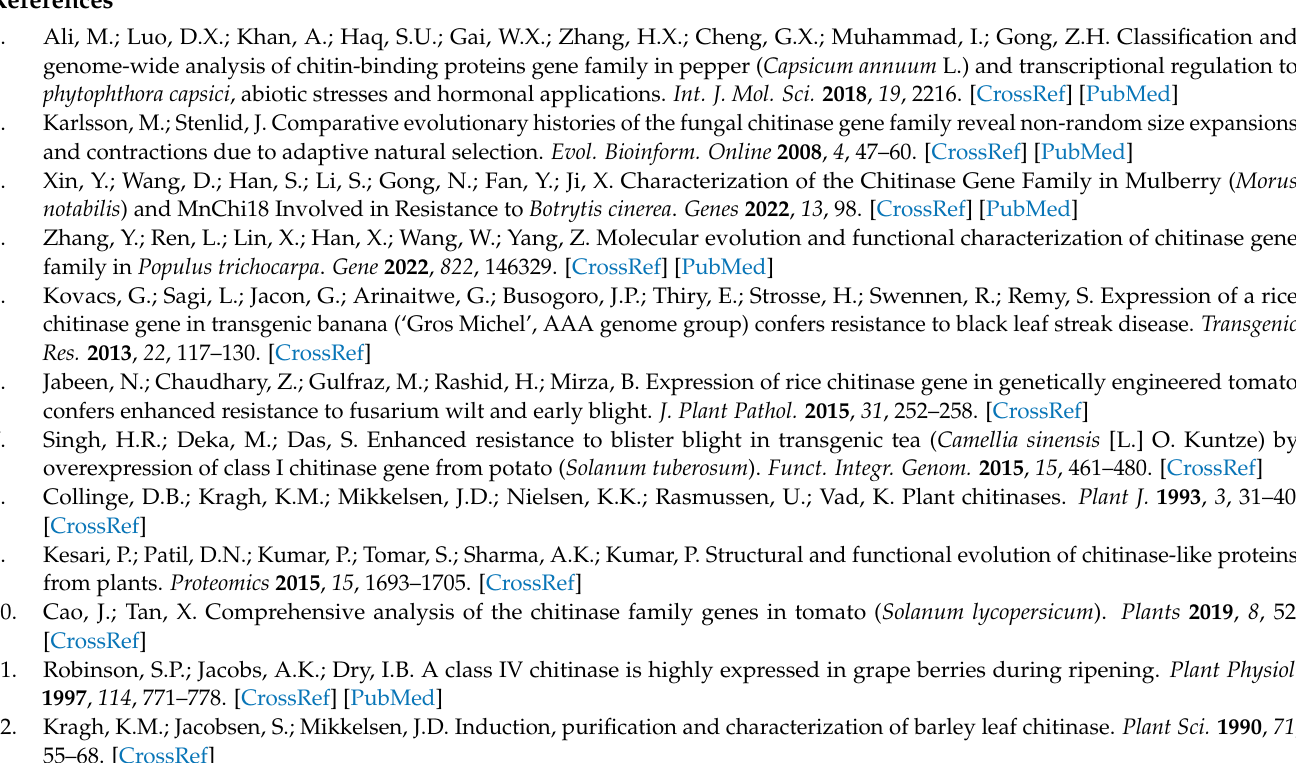
Table S7 . The qRT-PCR primer for PaCTLs . Table S8 . The amplification primer for PaCTLs